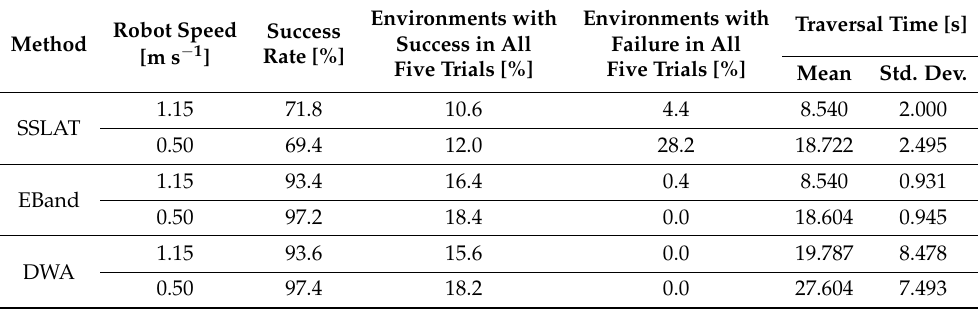
Figure 11. Comparison of three motion planning strategies using the first 100 environments of the BARN dataset [49]: SSLAT (blue), EBand (red) and DWA (green). In ( a ) the robot speed is limited to 0.50ms − 1 while in ( b ) it is limited to 1.15ms − 1 . The results for the 5 runs of each environment are shown for each method. In case of collision or timeout, the traversal time was set to 50s. The highlighted environments are the ones for which SSLAT was not able to find a solution. Table 1. Comparison of three motion planning strategies using the first 100 environments of the BARN dataset [49]. Each method was run five (5) times for each environment. The mean and standard deviation values only consider successful (no collisions/no timeout)